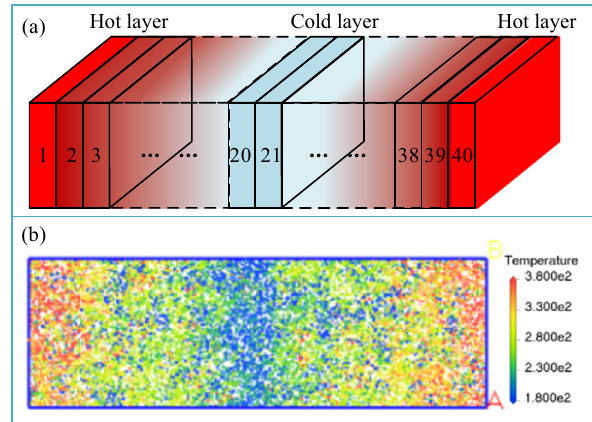
Figure 3: ( a ) Model diagram of RNEMD method. ( b ) The temperature distribution of the model along the z direction when the temperature gradient is stable.